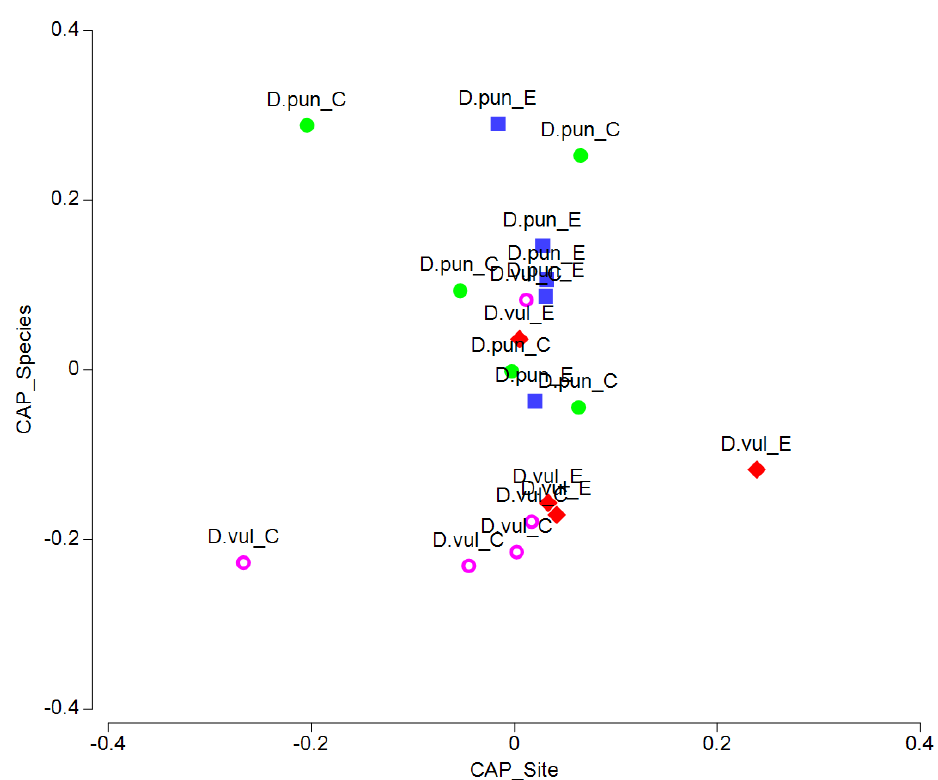
Figure 6. Canonical variate plot (CAP) for Ba and Sr element chemistry of the otolith of juvenile Diplodus puntazzo and Diplodus vulgaris sampled in 2018, grouped by “Site” and “Species”.